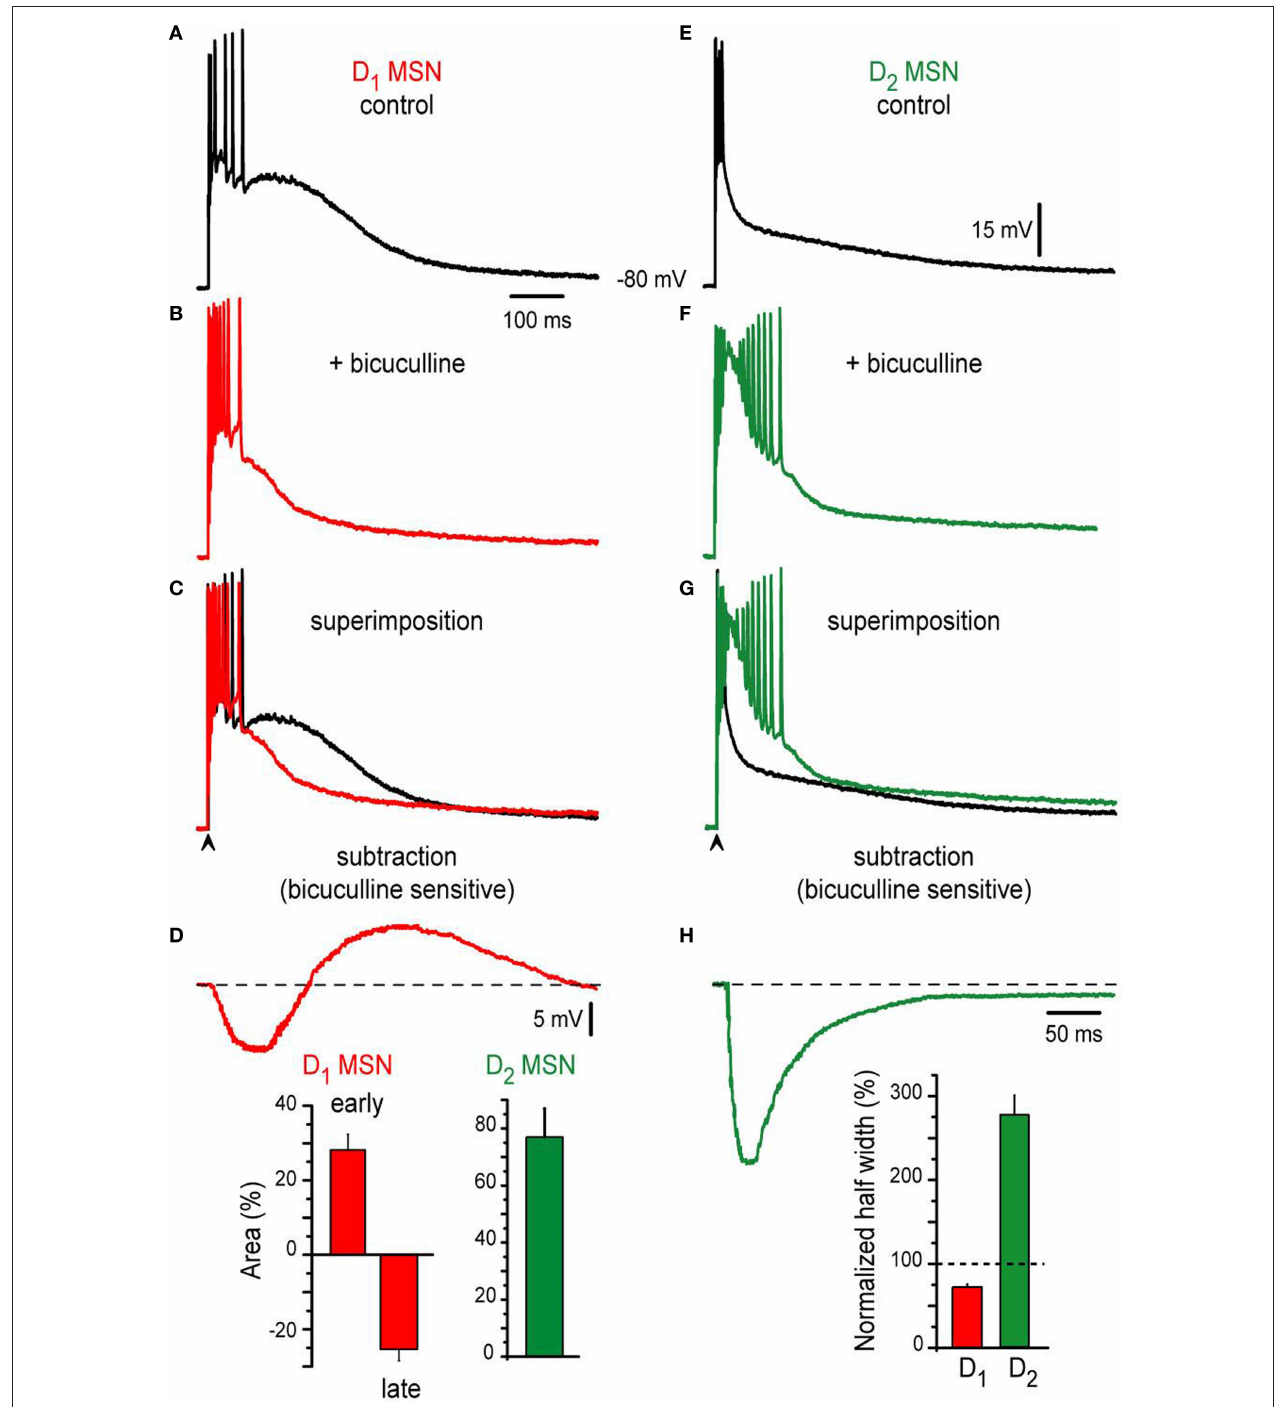
FiGure 2 | Contribution of synaptic inhibition differs in corticostriatal responses from D - and D -MSNs from BAC mice. (A,e) Suprathreshold 1 2 corticostriatal responses in D - and D -MSNs, respectively. (B,F) Addition of 10 μM 1 2 bicuculline to the bath saline (colored traces) changes both responses indicating that GABAergic events participate in each of them. (C,G) Superimposed records: (A) with (B) and (e) with (F) , show that GABAergic blockade mostly reduce D -MSNs response and enhance D -MSNs response, respectively. Notice 1 2 prolongation of action potentials trains in D -MSNs with inactivation of some 2